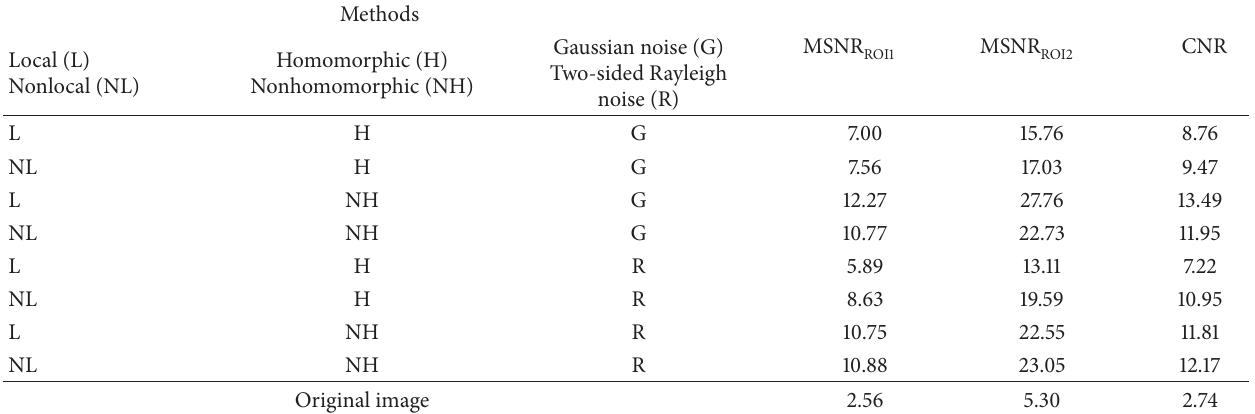
Table 1: The results of MSNR and CNR using several ROIs, shown in Figure 12.